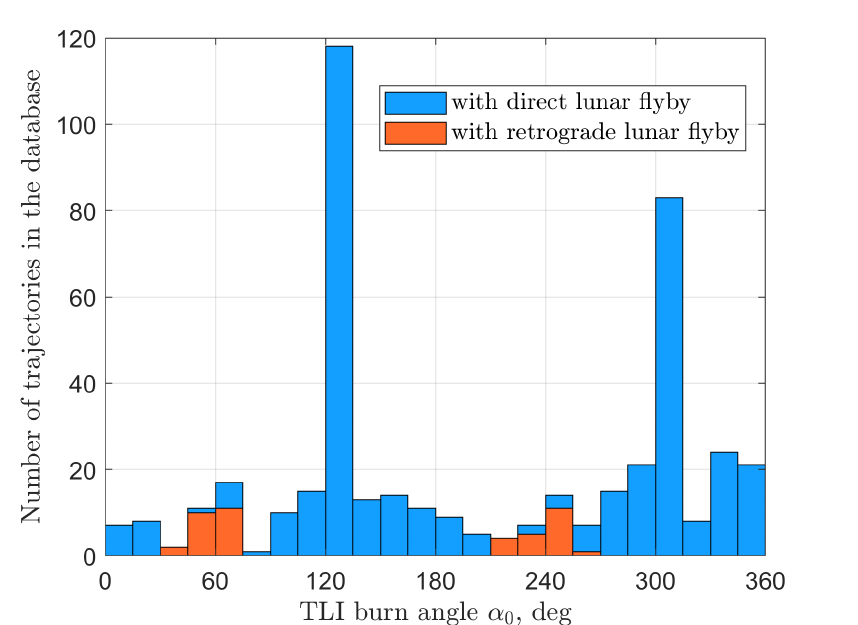
Figure 16. Distribution of spacecraft polar angle values at the moment of TLI burn execution for SALT trajectories including a lunar flyby. Two distinct peaks at about 130 deg and 310 deg correspond to the 4th and 2nd quadrant trajectories with a direct flyby. The burn angle for retrograde flyby trajectories can be either close to 60 deg (2nd quadrant trajectories) or about 240 deg (4th quadrant